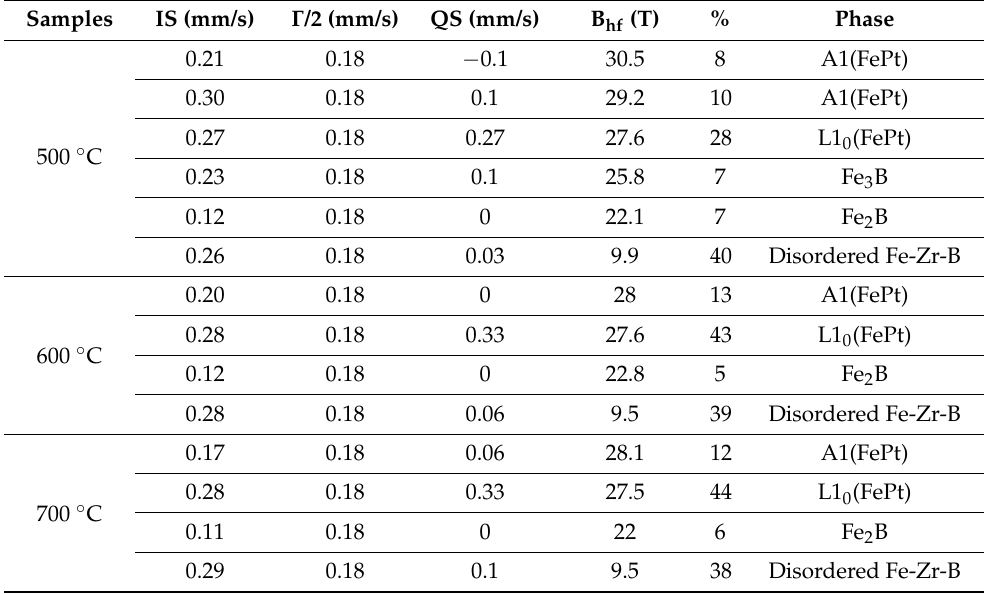
Table 3. Hyperfine parameters as resulted from fitting of the Mössbauer spectra (Figure 6).